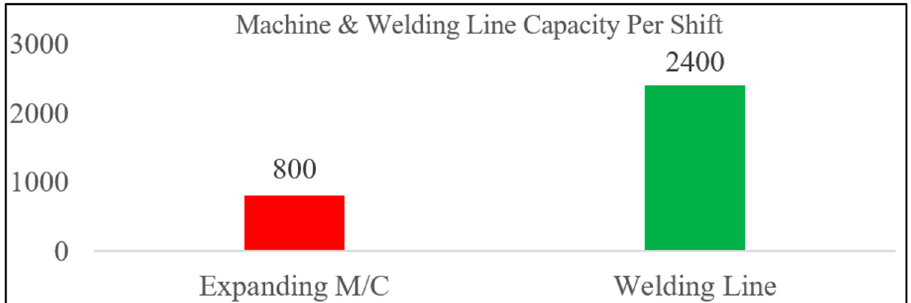
Figure 3. The capacity of expanding machine and welding line.